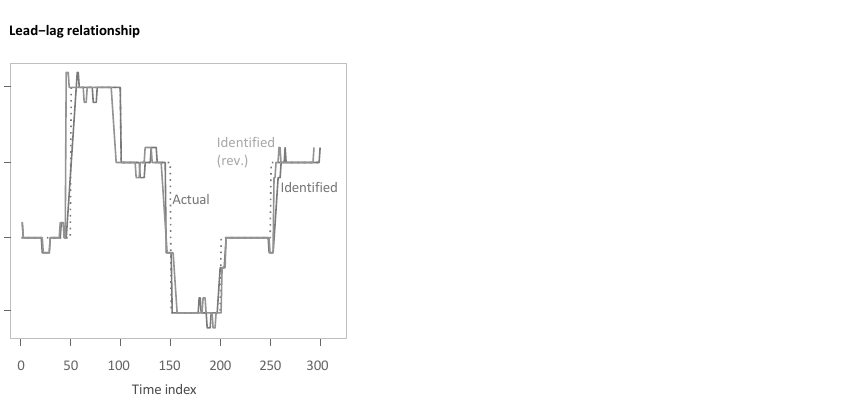
Figure 6. Time-dependent lag structure estimate through main